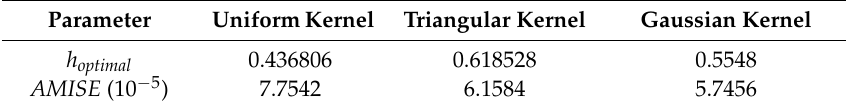
Table 5. Results of several kernel functions. AMISE , asymptotic mean integrated square error. Parameter Uniform Kernel Triangular Kernel